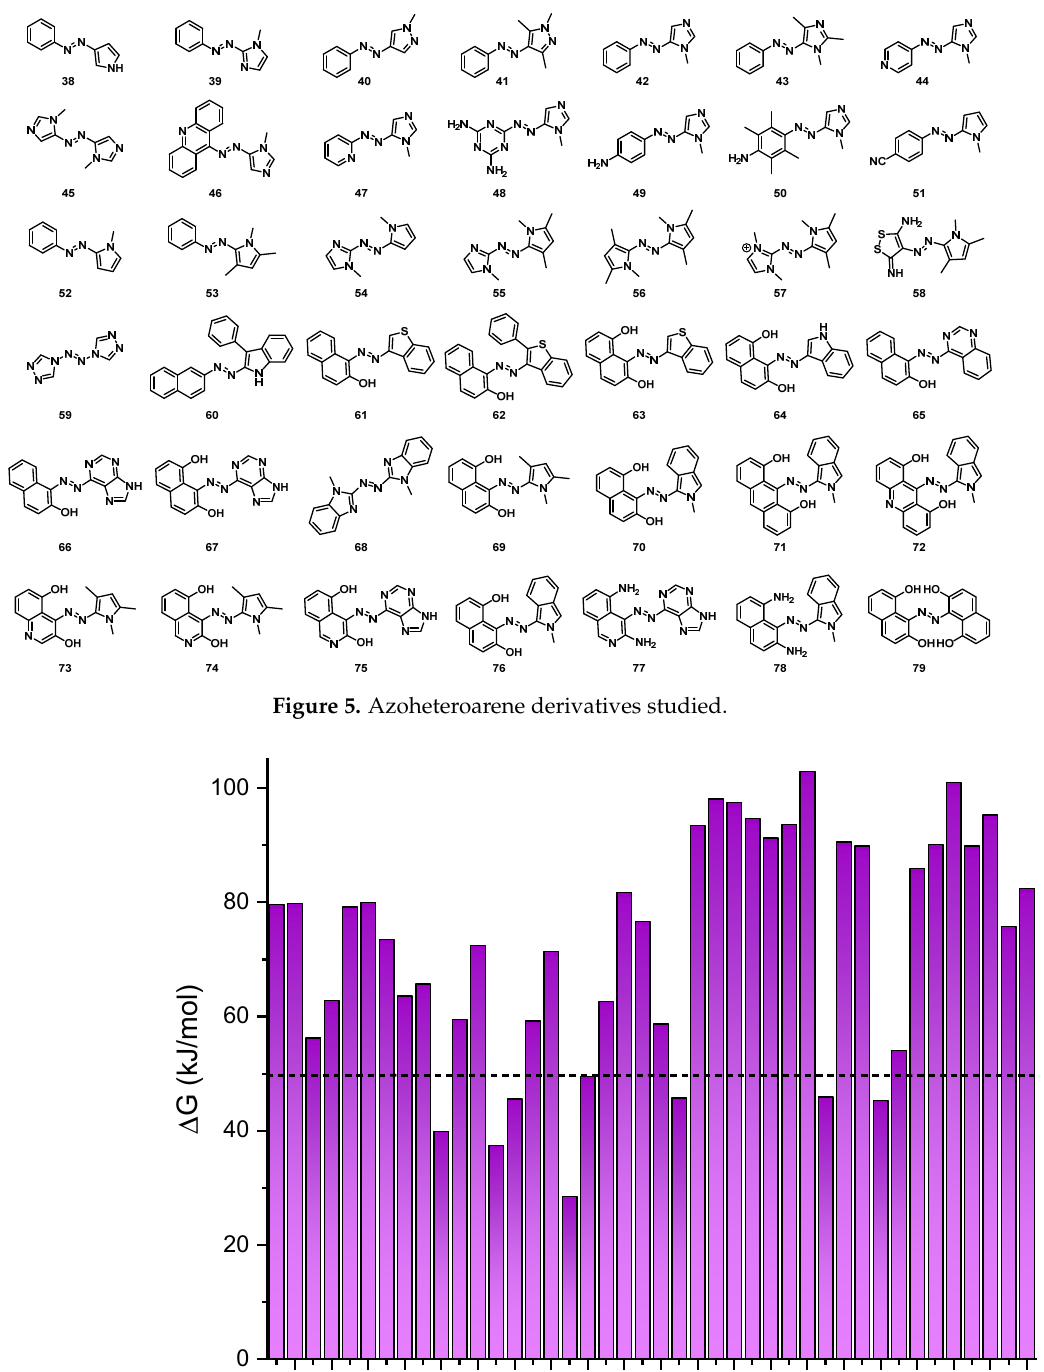
Figure 6. Energy difference achieved with different azoheteroarenes. The dashed line represents azobenzene. In all cases the most stable one is the E